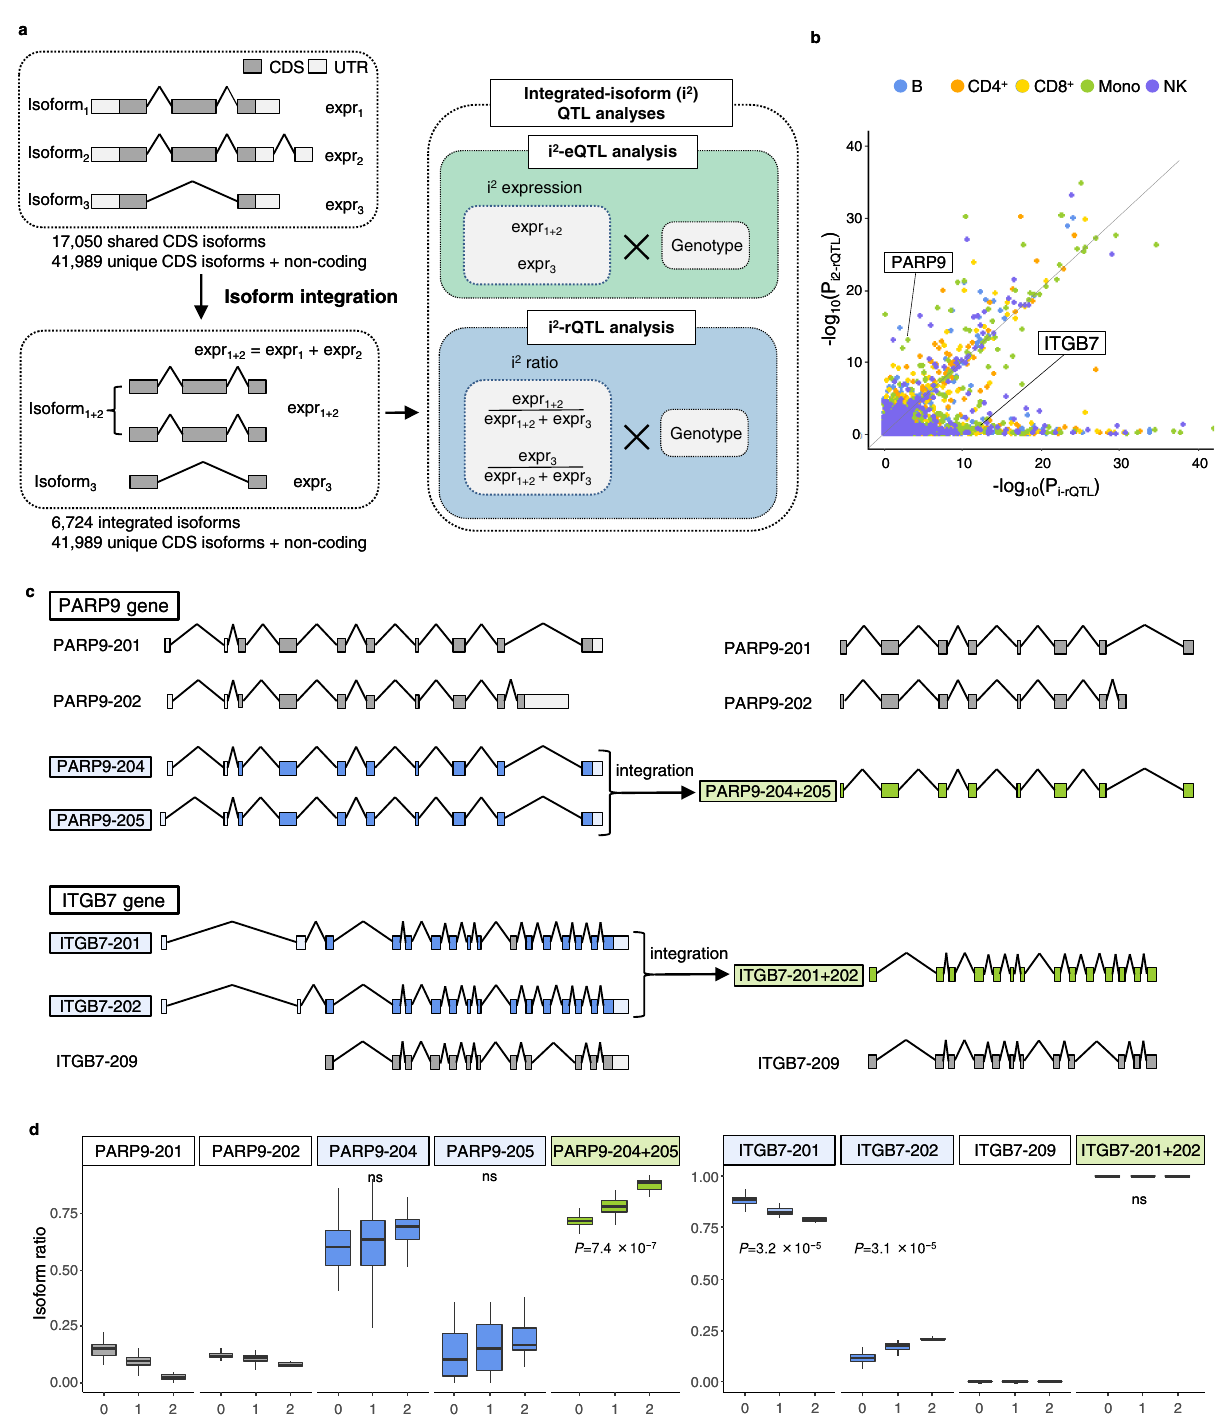
Fig. 3 | Integration of isoforms (i 2 ) by shared CDS; i 2 -eQTL analysis and i 2 -rQTL analysis.a TherearethreeisoformsofgeneA:isoforms1,2,and3.Isoforms1and2 havethesameCDS.ExpressionsofisoformswiththesameCDSwerecombinedand used forcorrelationanalysis(i 2 -eQTLanalysis,integrated-isoformeQTLanalysis;i 2 - rQTLanalysis,integrated-isoformratioQTLanalysis). b Comparisonofthe p -values ofthecorrelationanalysisbeforeandaftertheintegrationofisoforms.The p -values of isoforms before integration were the minimum of the i-rQTL p -values of each integratedisoform. c , d PARP9-204 and PARP9-205 havethesameCDSandwerenot